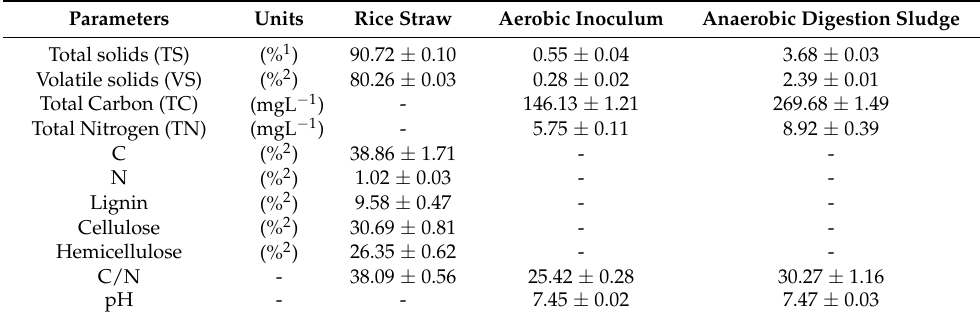
Table 1. Physicochemical properties of rice straw and inoculums.